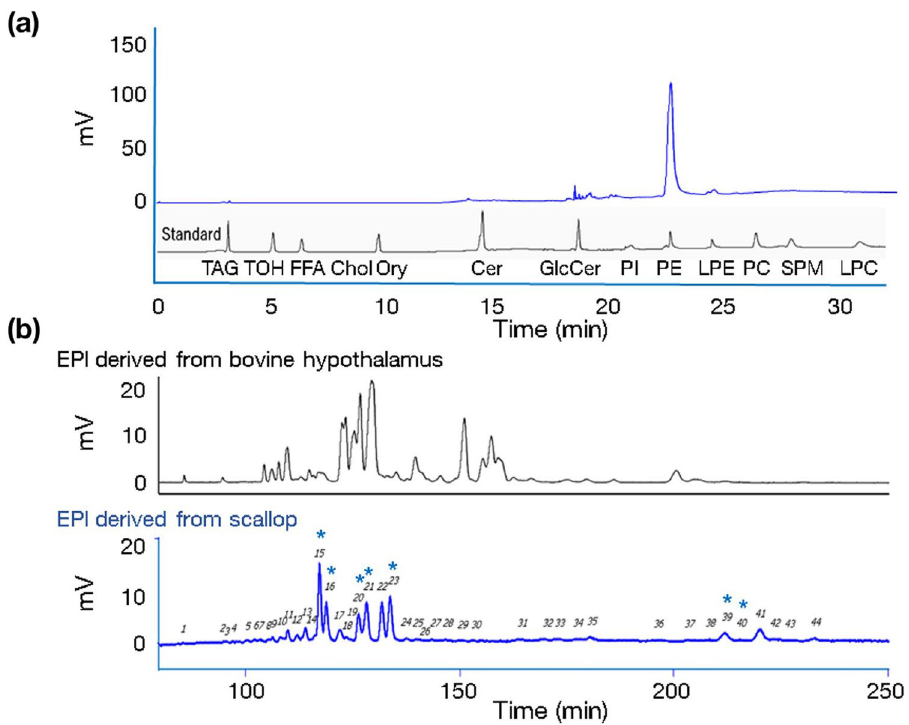
Figure 3. Chromatograms depicting examples of HPLC profiles of scallop-derived EPl. ( a ) Scallop-derived EPls were analyzed using the 2D LC–MS system. The chromatograms depict an example of a first-dimensional HPLC (normal-phase HPLC and a charged aerosol detector) profile of the extracted EPl-rich lipids and 13 lipid standard compounds. ( b ) The lower figure depicts an example profile of second-dimensional HPLC separation (reverse-phase HPLC and a charged aerosol detector) of the EPls molecular species in the phosphatidylethanolamine fraction of scallop EPls, eluted from the first-dimensional HPLC column with 44 peaks. The peaks correspond to the components listed in Table 2. The upper figure depicts second- dimensional HPLC separation of the EPls molecular species in the phosphatidylethanolamine fraction of the heifer brain (details published previously 8 ), for comparison. The blue asterisks indicate identifiable EPls molecular species unique to the scallop and absent in the bovine brain (details are presented in Table 2). 2D LC–MS, two-dimensional liquid chromatography-mass spectrometry; HPLC, high-performance liquid chromatography; mV, milli-voltage; scallop EPl, scallop-derived ethanolamine plasmalogen; TAG, tripalmitin; TOH, D-α-tocopherol; FFA, palmitic acid; Chol, cholesterol; Ory, cycloartenyl ferulate; Cer, ceramide; GlcCer, glucosylceramide; PI, phosphatidylinositol; PE, 1,2-dipalmitoyl- sn -glycero-3-phosphoethanolamine; LPE, 1-palmitoyl-2-hydroxy- sn -glycero-3-phosphoethanolamine; PC, 1,2-dipalmitoyl- sn -glycero-3-phosphocholine;